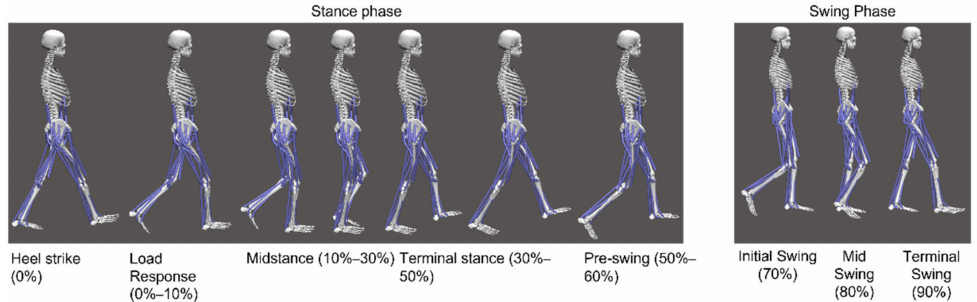
Figure 4. An OpenSim generated diagram for the stance and swing phase of the gait